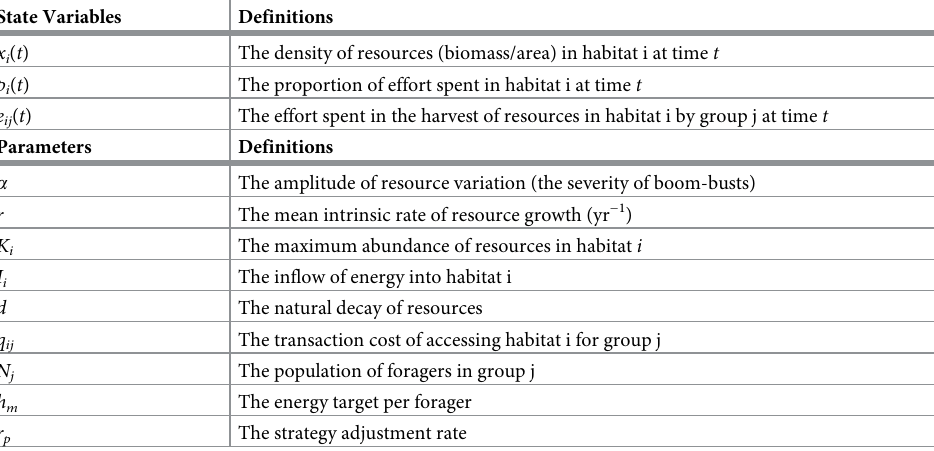
Table 1. Model state variables and